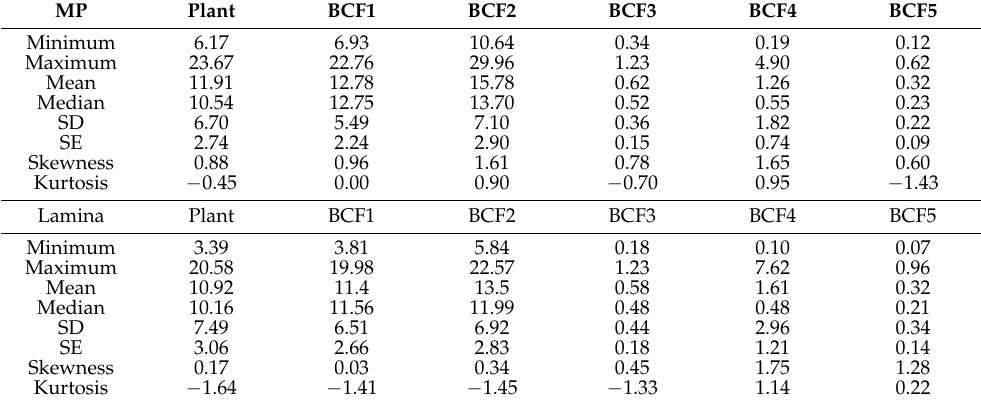
Table 11. Overall statistics of lead (Pb) concentrations (mg/kg dry weight) in the midrib plus petiole (MP), and lamina of Avicennia officinalis , and their bioconcentration factors (BCF) values, collected from 6 sampling sites in the mangrove areas of west coast of Peninsular